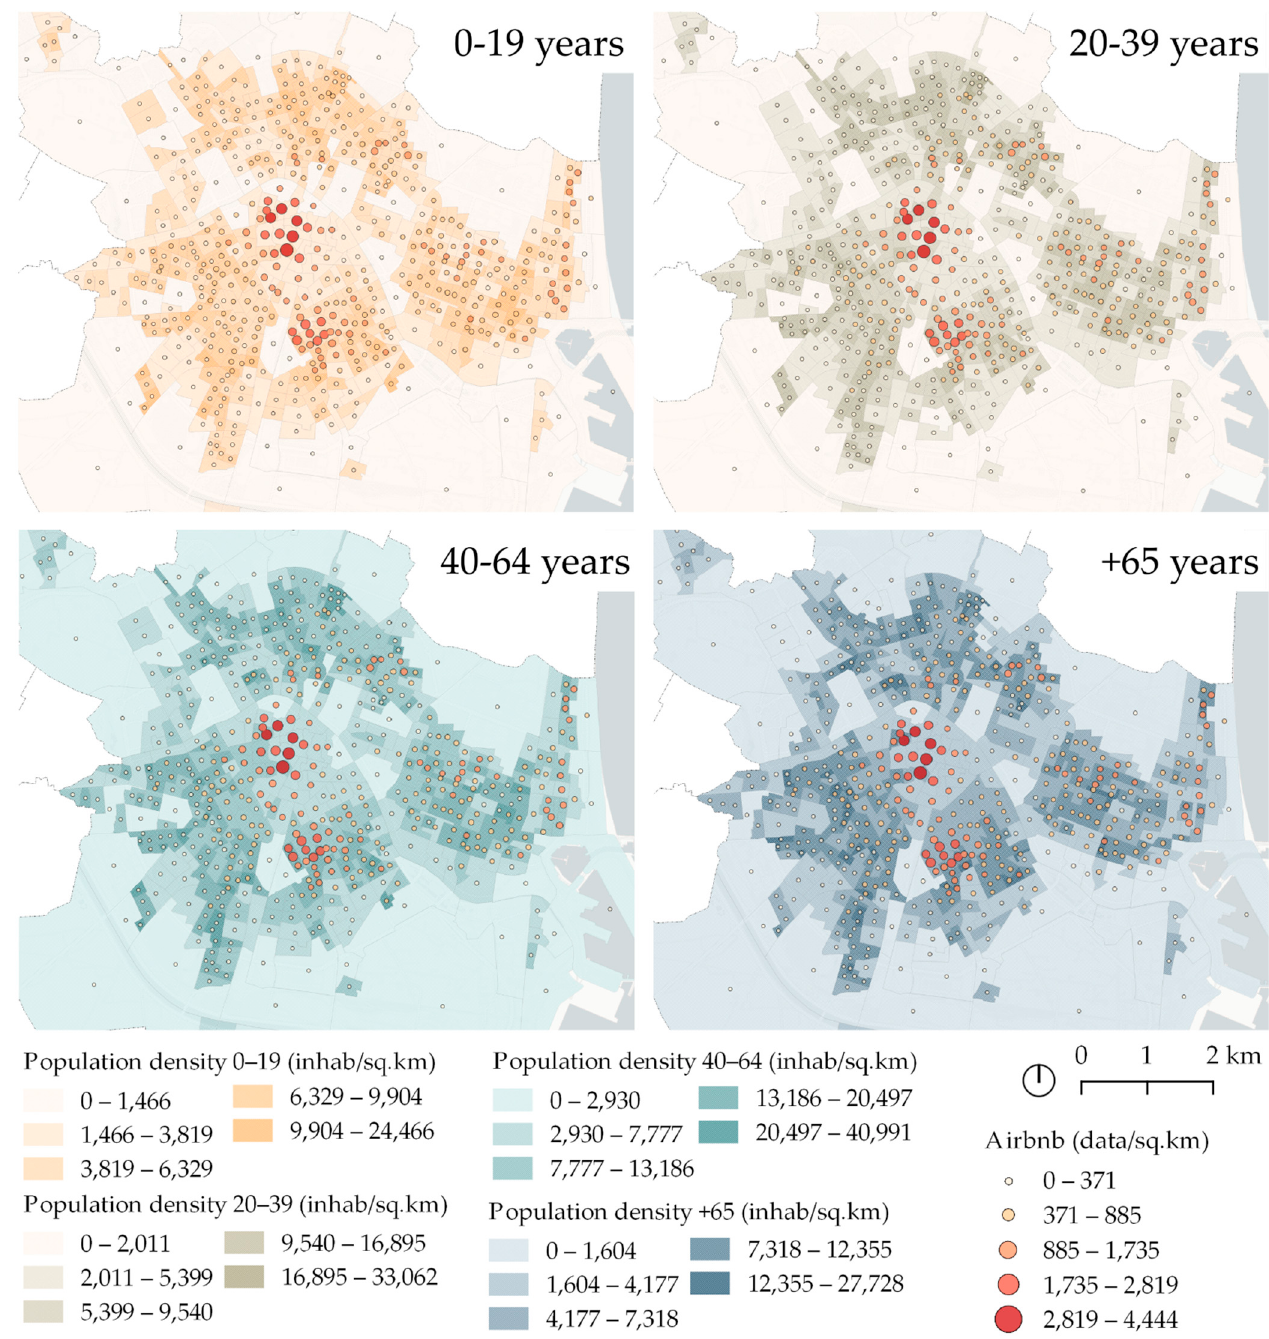
Figure 8. Population density per age group and Airbnb data density.